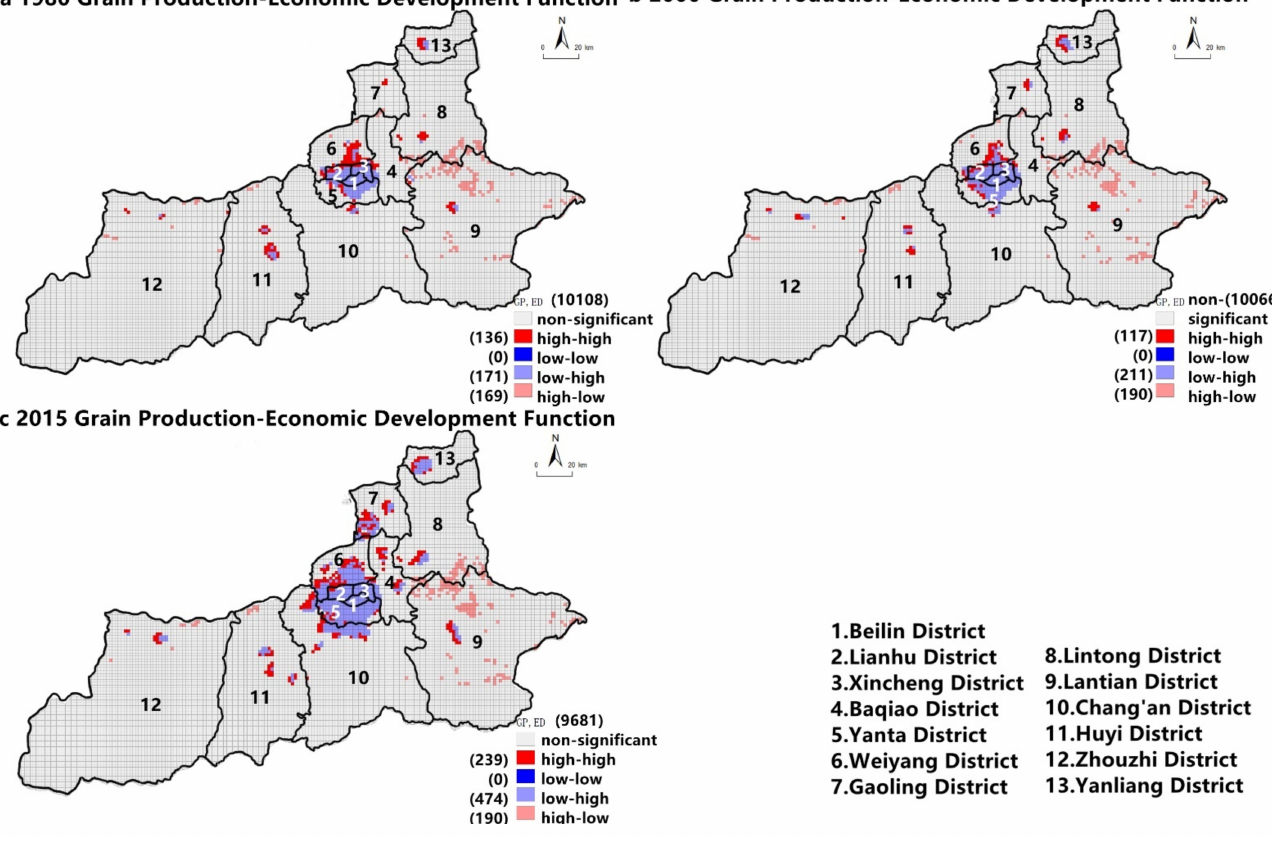
Figure 8. LISA map of the Land system Grain Production-Economic Development Function of Xi’an city from 1980 to